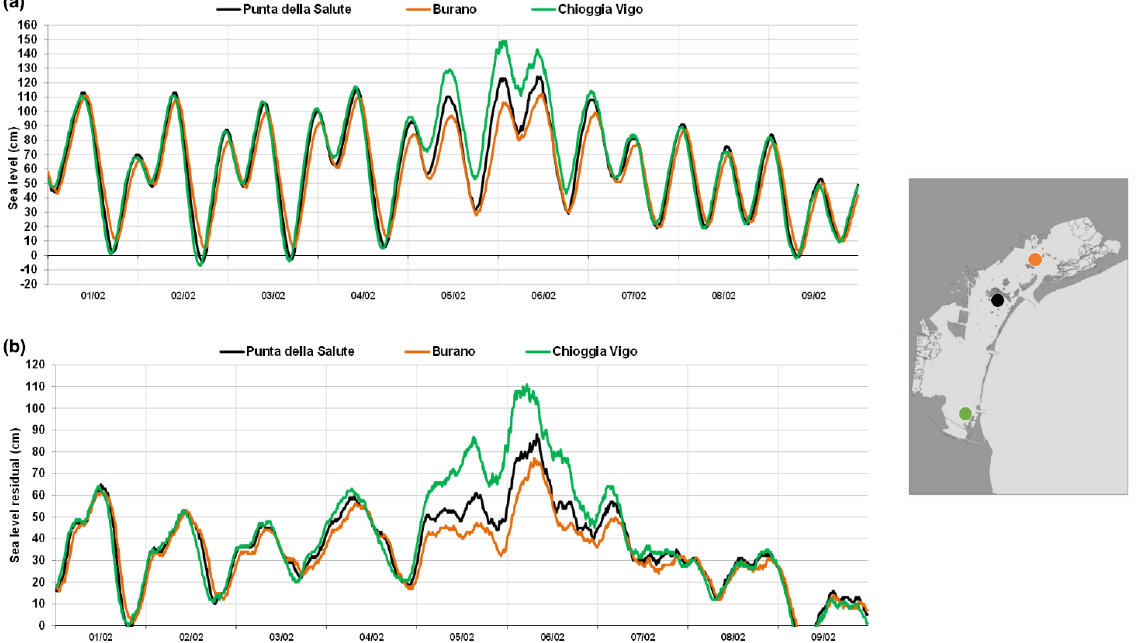
Figure 7. Sea level (a) and residual level (b) at Venice–Punta della Salute (blue), Burano (red) and Chioggia (green) during a bora event (wind from northeast) on February